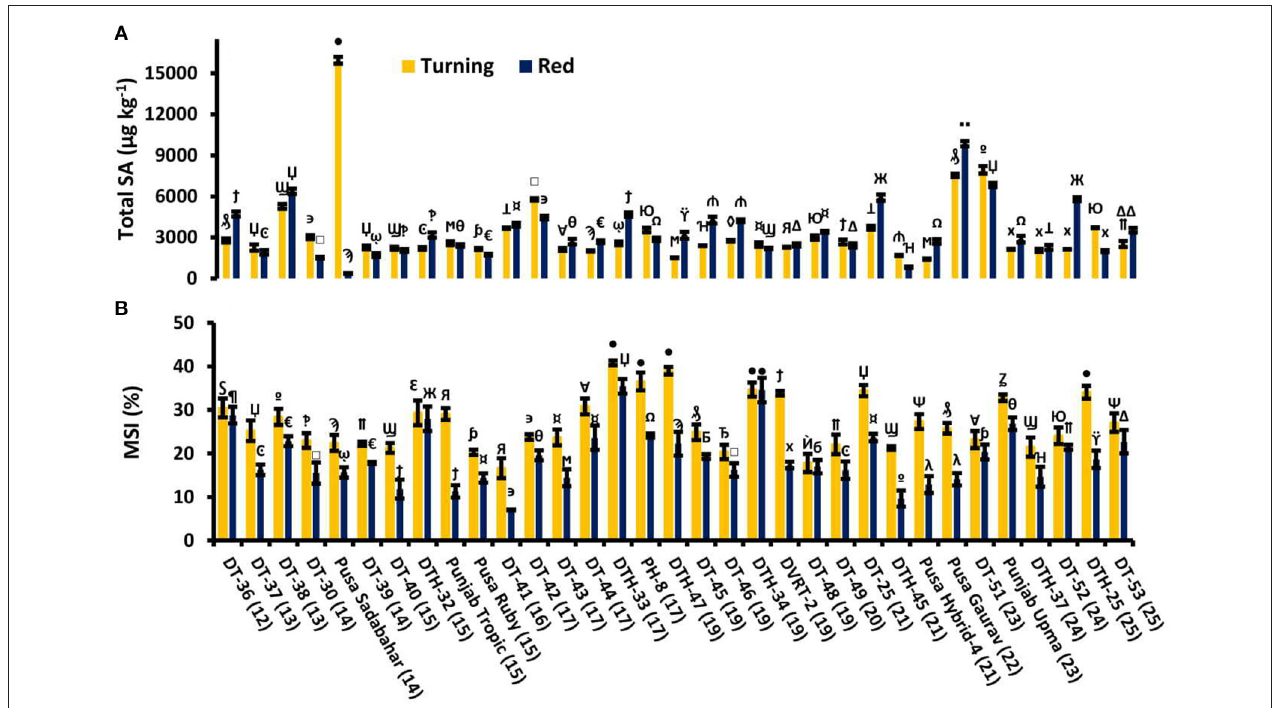
FIGURE 2 | Tomato lines with total salicylic acid (SA) at turning stage and the red stage of tomato fruit development (A) with their respective membrane stability index (MSI) (B) . Bottom axis represents the name of tomato lines, and numbers enclosed in parentheses represent shelf life. Each graph represents the mean of three replications, and vertical bars represent ± SE. Different symbols over the bars represent the significant differences at P < 0.05.